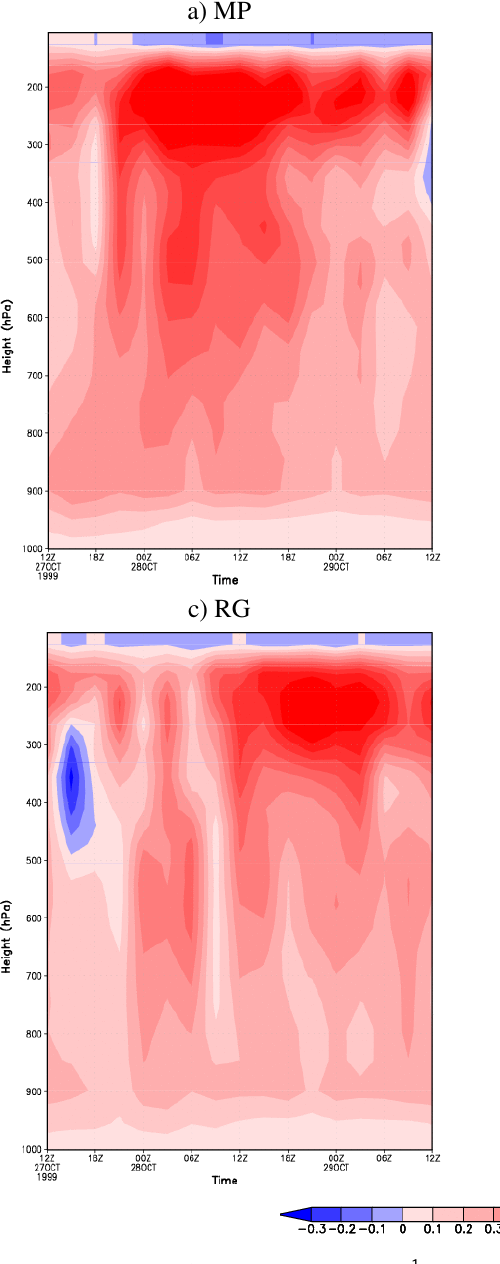
Fig. 14. Time-height cross section of vertical velocity in ms − 1 , averaged over the square area of 1 ◦ × 1 ◦ , in the storm core for the experiments of different MPS, namely (a) MP, (b) GG, (c) RG and (d)